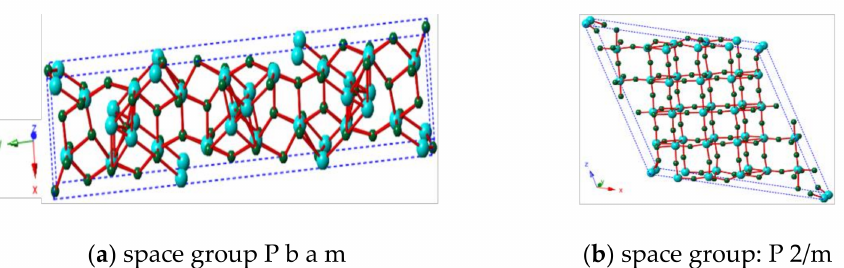
Figure 9. Nb 2 O 5 ( a ) orthorhombic and ( b ) monoclinic structures. Niobium—blue spheres; Oxygen— green spheres (adapted from